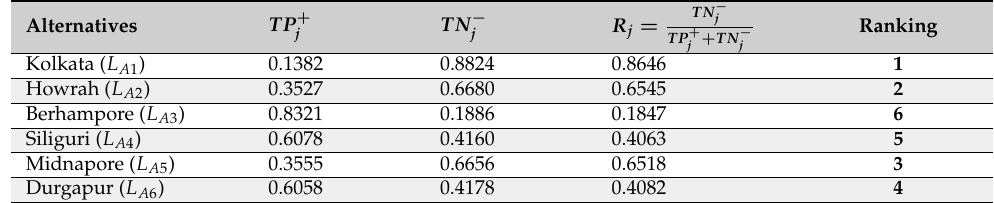
Table 18. Alternatives ranking with their adjacent data by using the NTOPSIS